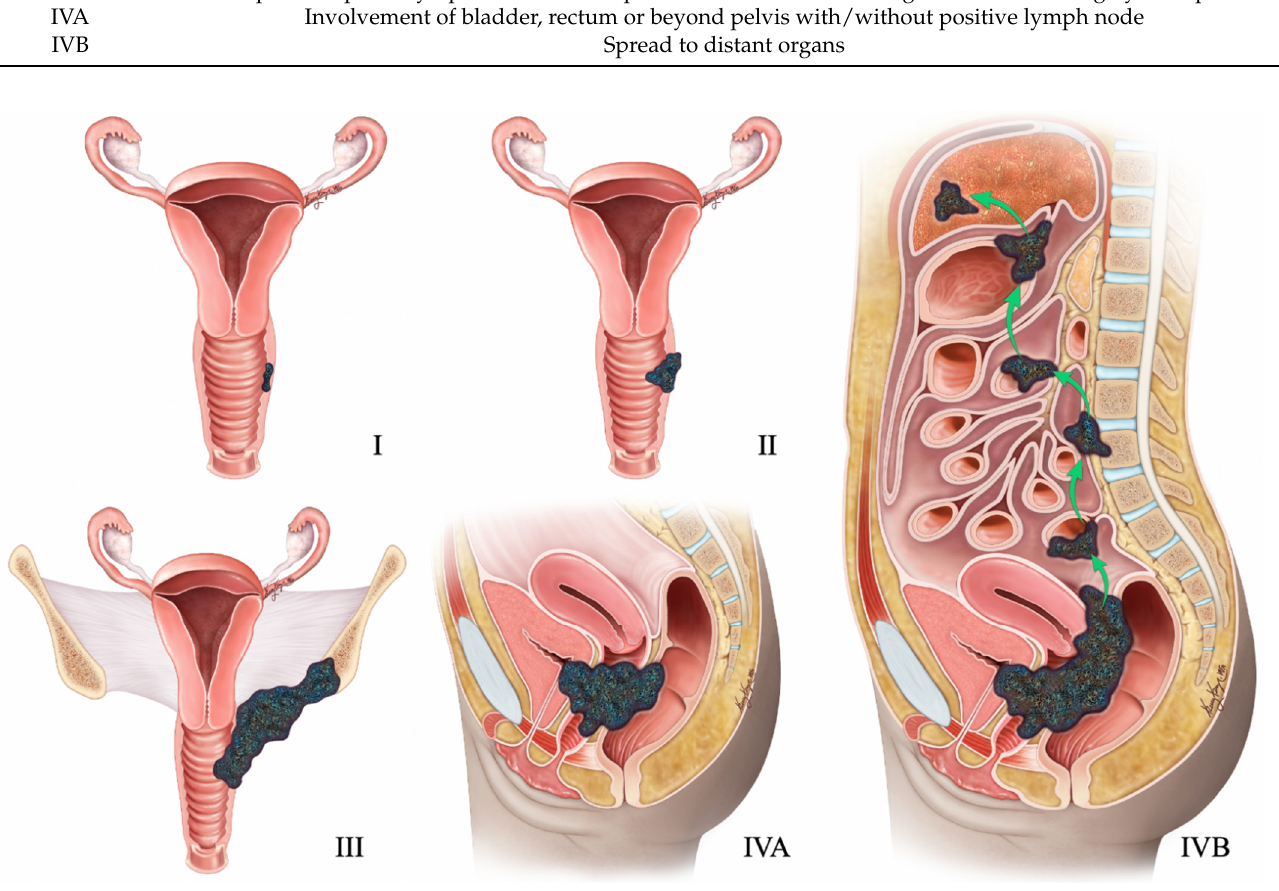
Table 12. American Joint Committee on Cancer (AJCC) staging of vaginal cancer.